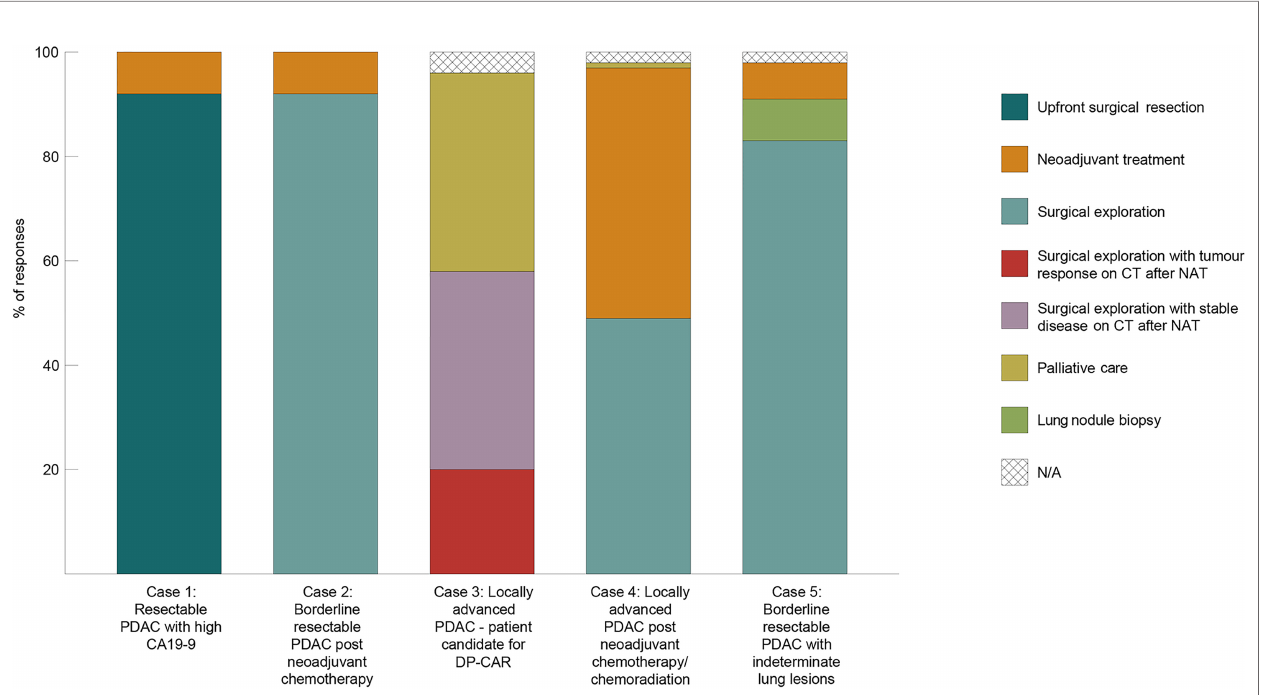
FIGURE 2 | Allocation of responses regarding PDAC surgical management in fi ve different clinical